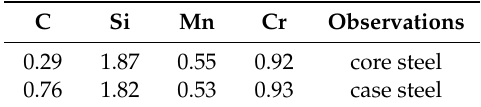
Table 1. Chemical composition of the steels, all in